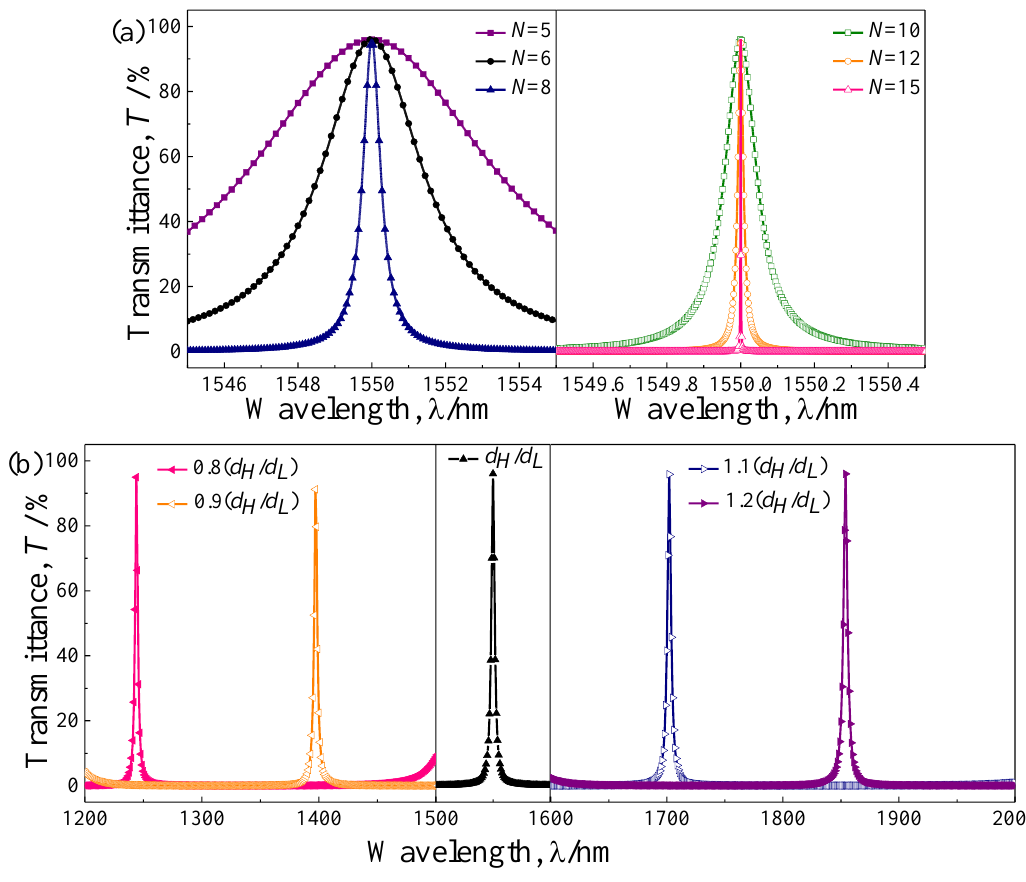
Figure 6. The transmission spectrum of the quasi-one-dimensional PC-based NBF with different parameters: ( a ) periodic number ( N ); and ( b ) thickness of two dielectric material layers.